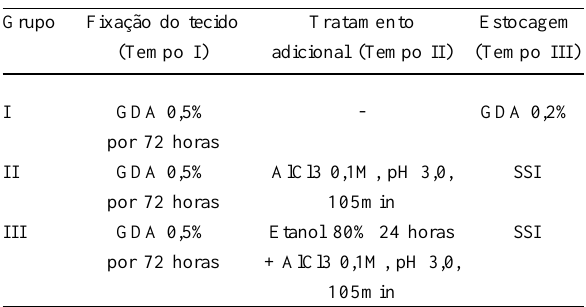
Tabela 1. Tratamento das valvas aórticas porcinas nos diferentes grupos.